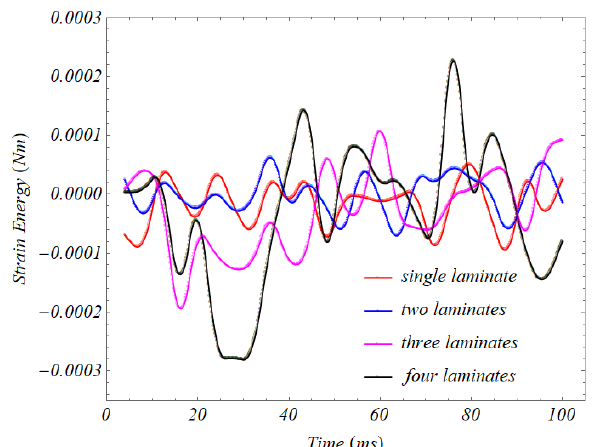
Fig. 10. Strain energy against time for various number of cellphone casing laminates at 2000 mm drop distance.